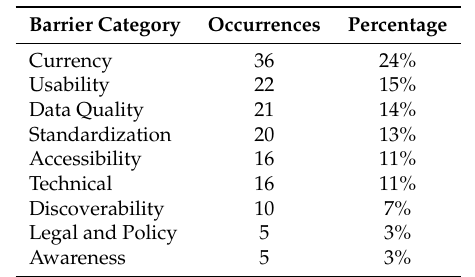
Table 6. Number of occurrences of the mentioned barriers by data users in the open question regarding the most common error/barrier when searching or using data from cities’ open data portals.